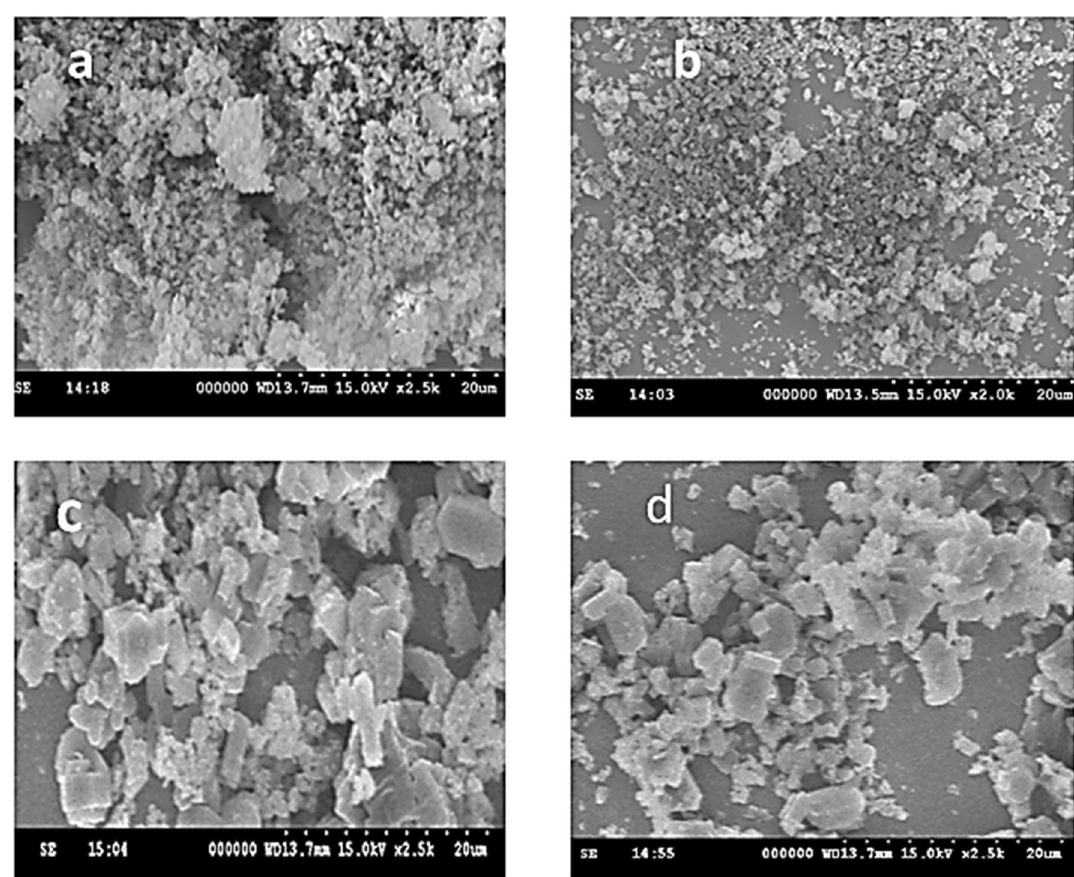
Figure 10. SEM images of synthesized ( a ) NT, ( b ) NT1, ( c ) NT2 and ( d )